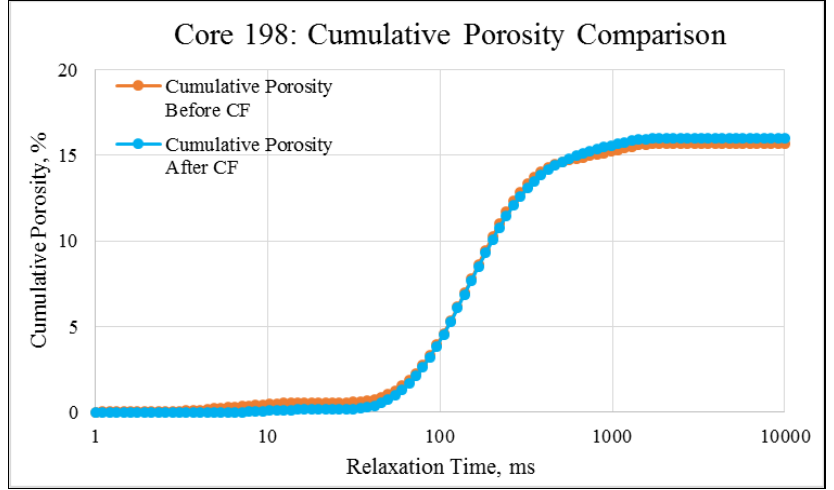
Figure 11. NMR cumulative porosity comparison of C#198: Before and after the coreflood. ICP-MS Analysis: Effluents from each mode of the coreflood were subjected to ICP- MS compositional analysis to compare pre-and post-flood concentrations of significant and potential determining ions (PDI) viz. magnesium, calcium, and sulfate. In carbonate- rock- and sulfate-rich aqueous systems, the potential of the surface is determined by the activity of these ions because they can either dissolve or deposit on the rock surface, in- fluencing the surface potential [52]. The ICP-MS study was vital in discerning the rock dissolution process during flooding [53]. ICP analysis of injection and produced brine from CF-1 and CF-2 are presented in graphical form in Figures 12–17. Figures 12–14 depict Mg, S, and Ca concentrations in injection and effluent brines in CF-1. Figures 12 and 13 show a significant increase in Ca and Mg ion concentration in produced brine compared to the injection brine (SW). Since seawater is severely under- saturated with Ca and Mg ions, this dissolution was expected and a possible reason for high oil recovery in the secondary recovery stage. Here, seawater may act as low-salinity water because its salinity is nearly one-fourth of that of the formation water. In addition, during the tertiary and quaternary recovery stages, Ca and Mg ions are higher in pro- duced water than in the base water. (It should be kept in mind that Ca and Mg concentra- tion in CESW is the same as SW.) This must have resulted from the continuous dissolution of these ions during all three modes of oil recovery. At the same time, sulfur concentration is found in reduced concentration (Figure 14) at all stages of flooding compared to its concentration in injected brine. Similar results are observed from the brine analysis of CF- 2, in which the positively charged ions (Ca and Mg) are dissolved in all flood modes, re- sulting in significantly higher concentration in the produced brine compared to injection brine (Figures 15 and 16). Simultaneously, negatively charged sulfate ions are deposited on the positively charged carbonate rock, resulting in a reduced concentration of sulfur in the produced brine (Figure 17).